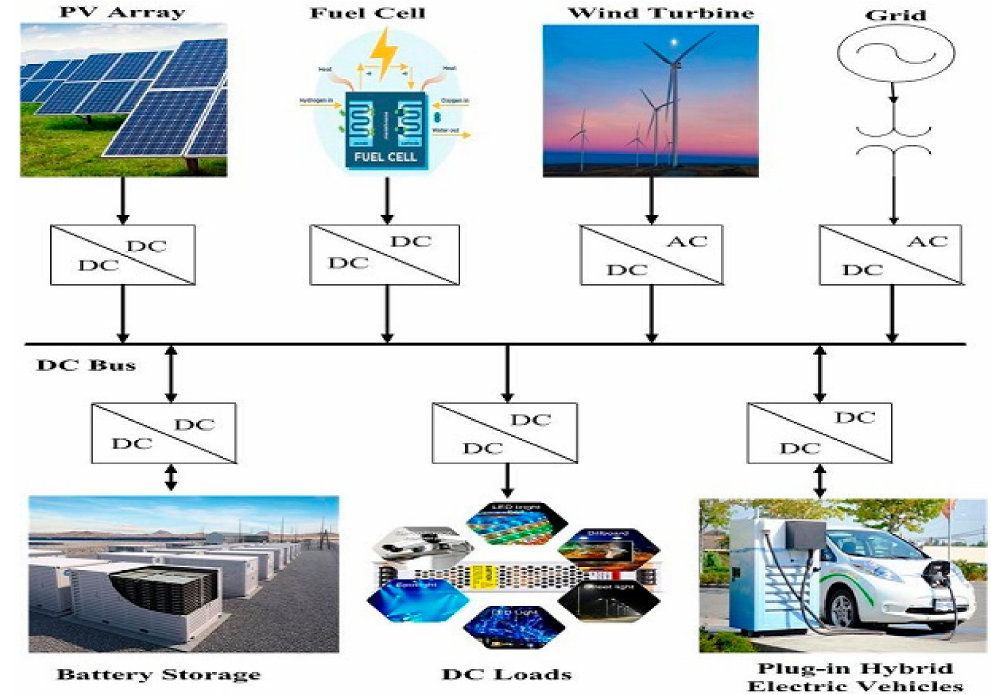
Figure 1. Architectural overview of LVDC